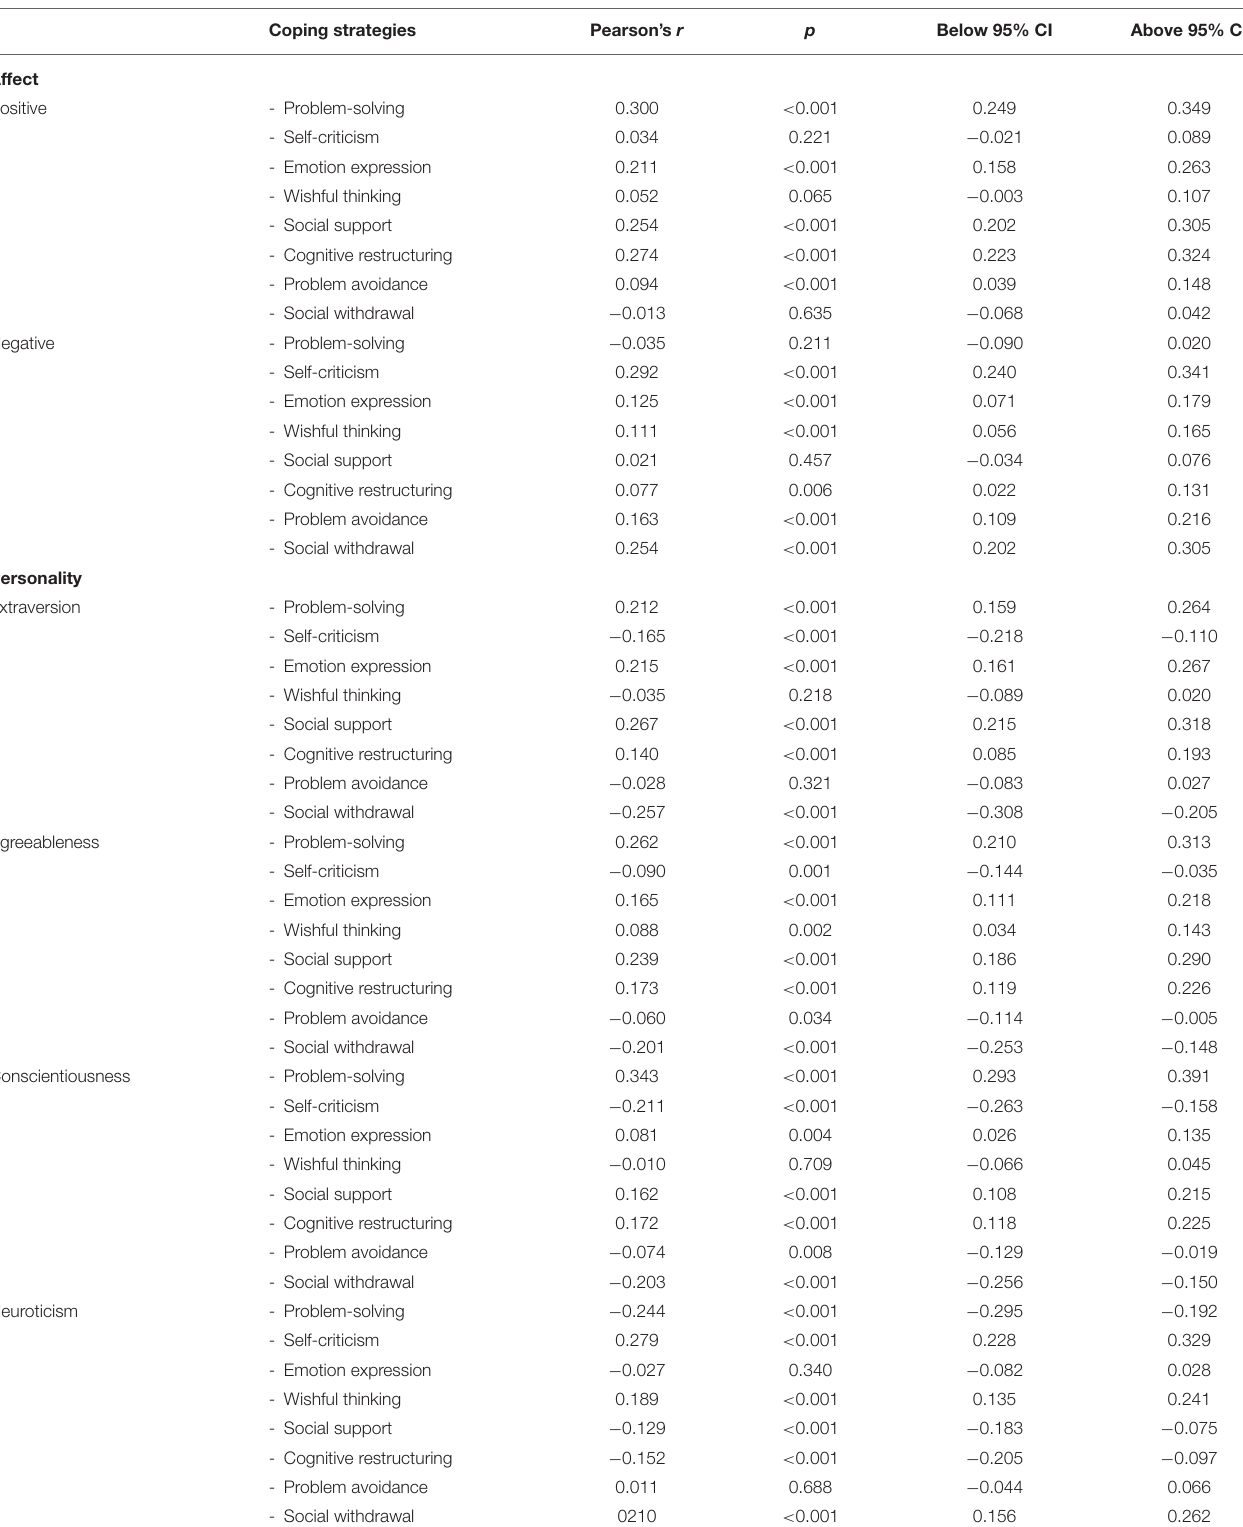
TABLE 2 | Affect, personality, and coping strategies—Pearson’s pairwise correlations. Coping strategies Pearson’s r p Below 95% CI Above 95%